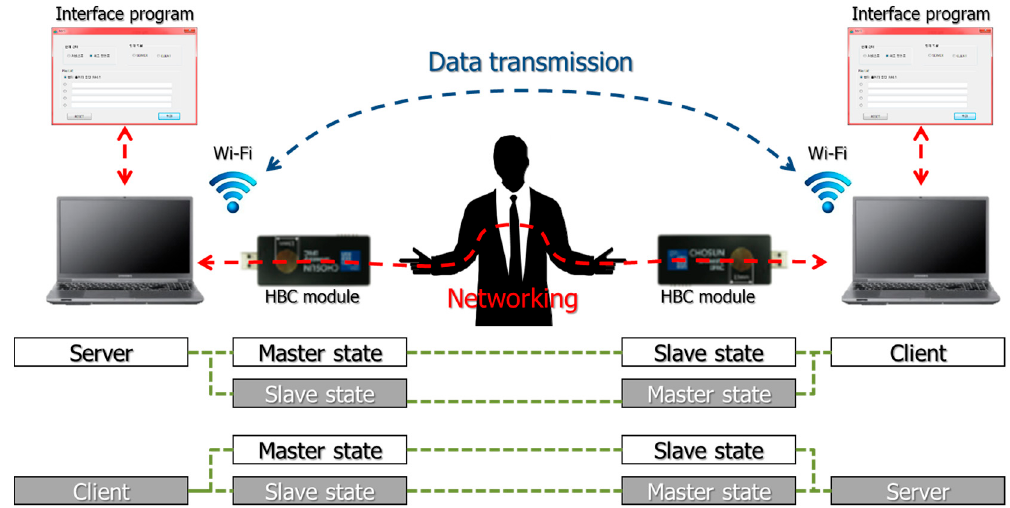
Figure 1. Touch-Based Dual-Band Communication System Diagram.